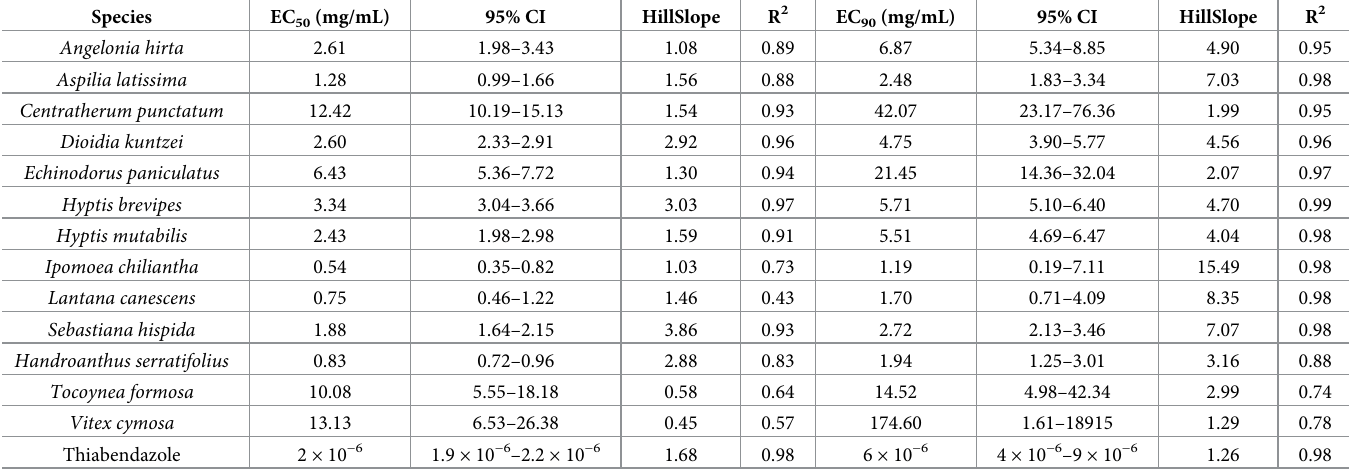
Table 3. Plant species, mean effective concentrations inhibiting hatchability of Haemonchus placei eggs by 50% (EC 50 ) and 90% (EC 90 ), confidence intervals, curve slopes (HillSlope) and coefficient of determination (R 2 ) obtained from serial evaluations of 10 concentrations.